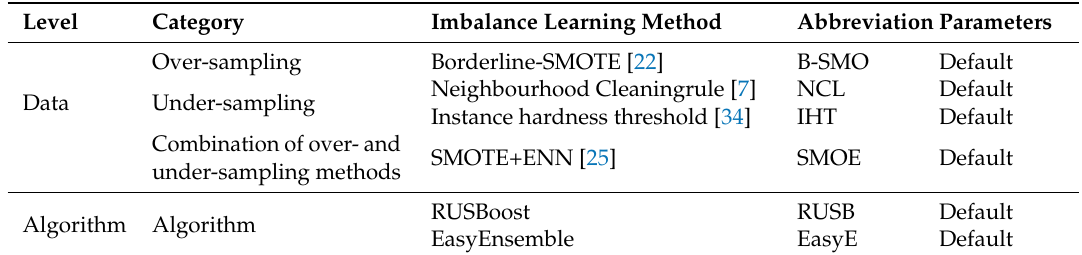
Table 7. Baseline imbalance learning methods.